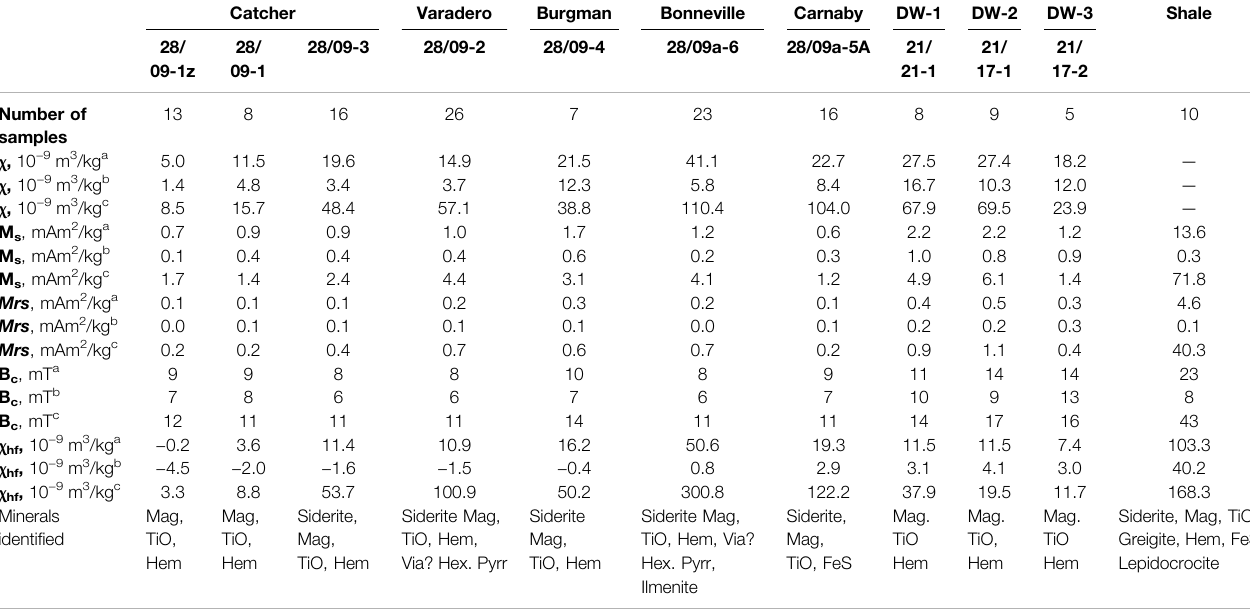
TABLE 2 | Mean, minimum and maximum values obtained for magnetic susceptibility and hysteresis parameters of the hydrocarbon reservoir, background and the surrounding shales samples.